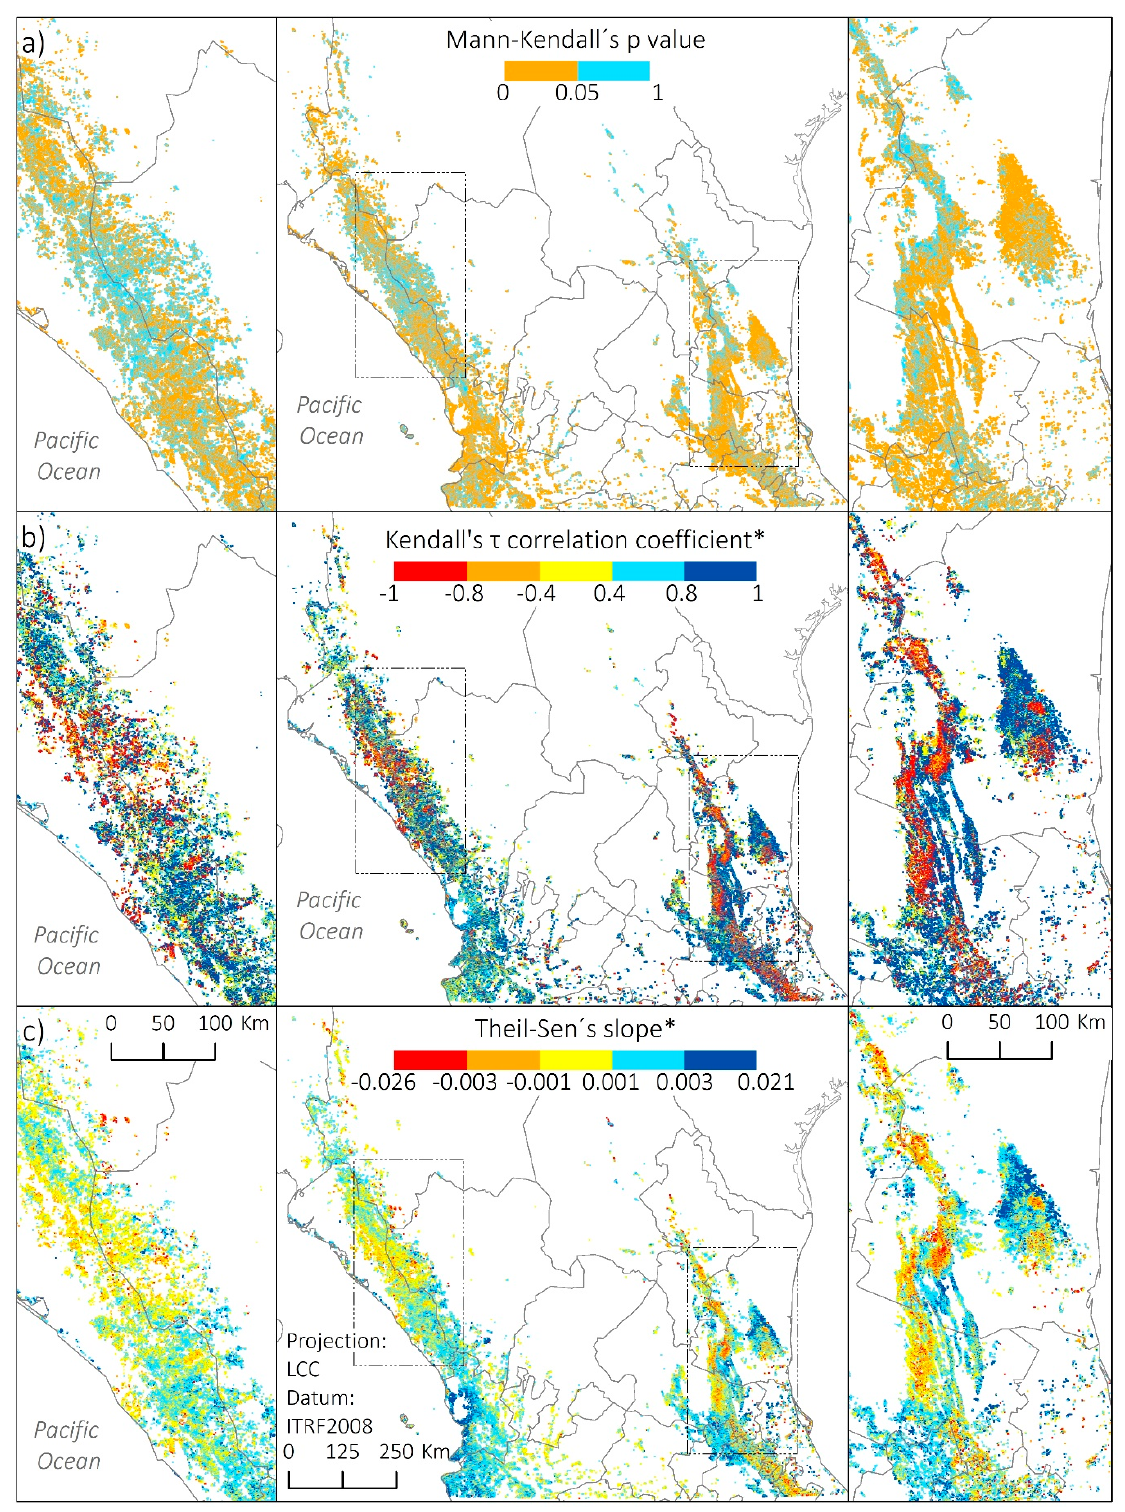
Figure 4. Significance of all trends ( a ). Strength ( b ) and magnitude ( c ) of trends at 95% confidence level or higher, 2002–2017.